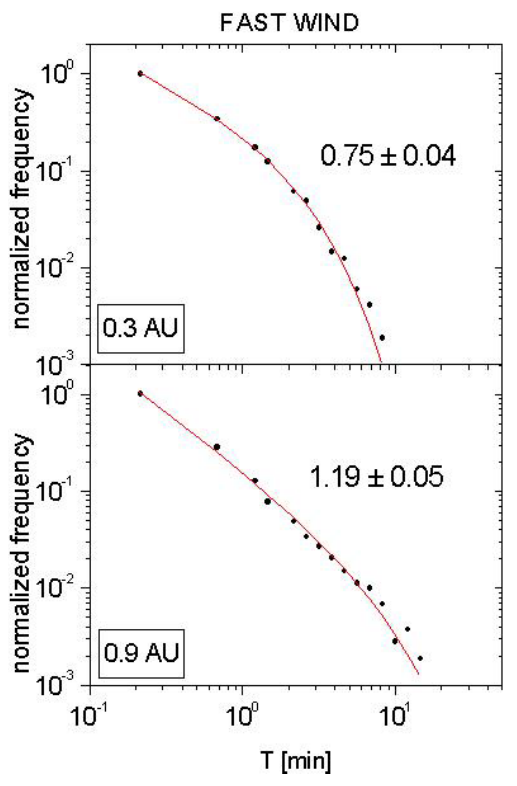
Fig. 3. Waiting time distributions of B s for fast wind at different radial distances. The slope of the power law is indicated in the picture. The points are derived from an average of the histogram over logarithmically equally spaced intervals and are normalized to the maximum value. Table 3. Parameters of the fit: fast wind. T c is expressed in min.